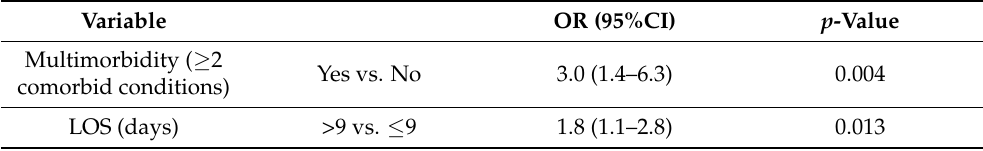
Table 3. Results from multivariable logistic model for polytherapy. OR = odds ratio; LOS = length of stay in hospital